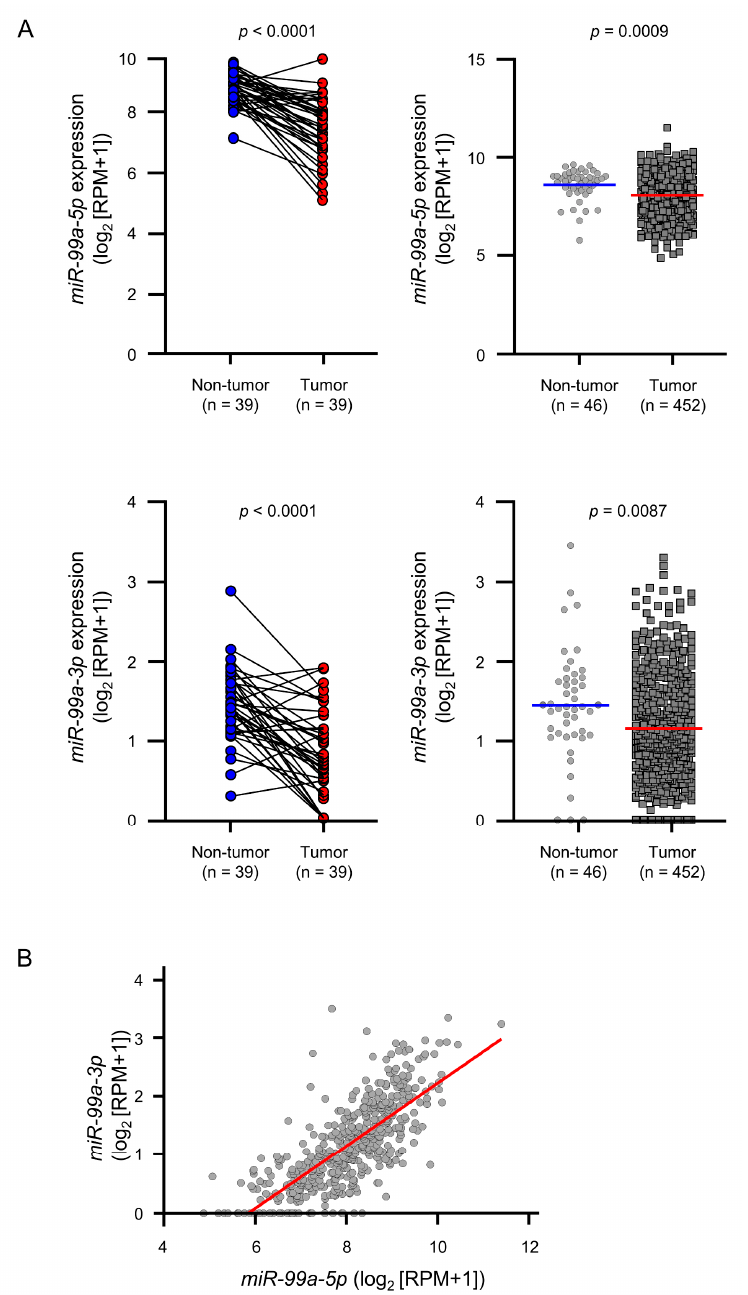
Figure 1. Downregulation of miR-99a-5p and miR-99a-3p in LUAD. ( A ) Comparison of the expression levels of miR-99a-5p and miR-99a-3p between tumor and non-tumor tissues in paired (left) and non-paired (right) LUAD clinical specimens from TCGA datasets. ( B ) Positive correlation between the relative expression level of miR-99a-5p and that of miR-99a-3p in clinical specimens according to Spearman’s rank tests.